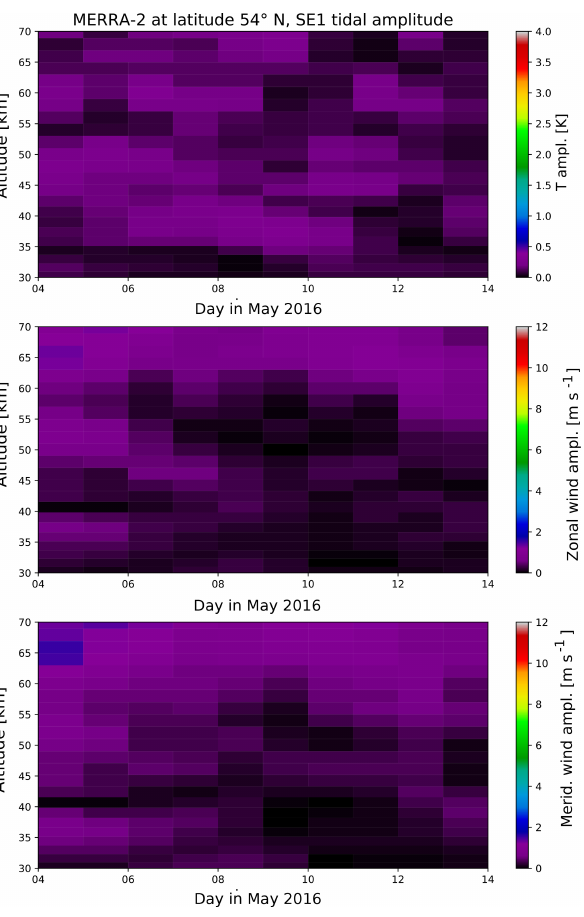
Figure A9. DE3 amplitude in temperature, zonal and meridional wind from global MERRA-2 fields at the latitude of 54 ◦ N.